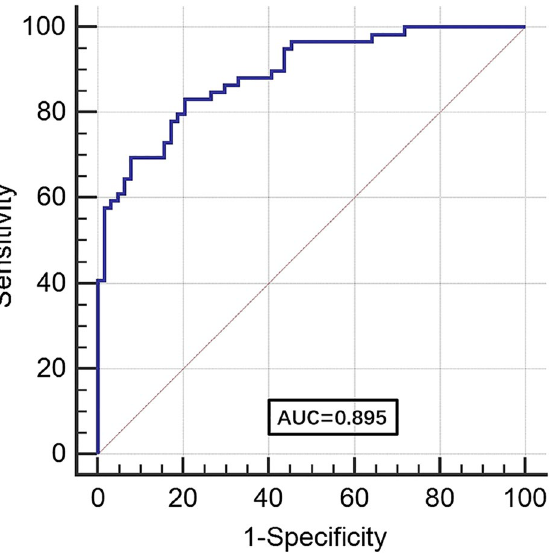
Figure 1. The AUC of PaO2/FiO2 in all patients (AUC = 0.895 (95% CI: 0.826–0.943, p < 0.0001)). Abbreviations: AUC: area under the curve; PaO2/FiO2: oxygenation index.